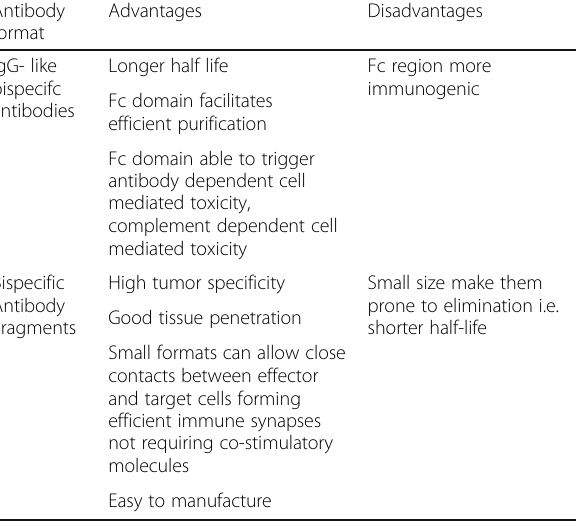
Table 3 Comparing different formats of bispecific antibodies Antibody